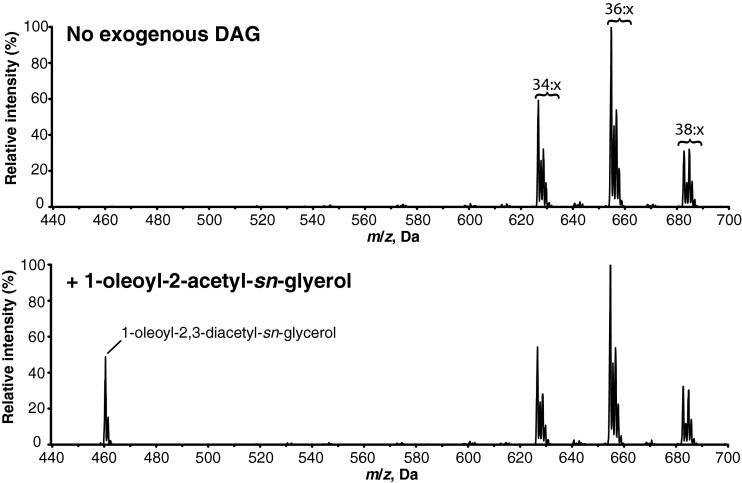
EaDAcT can acetylate DAG containing an sn-2 acetyl-groupPositive ESI mass spectra obtained from the neutral loss of ammonium acetate from lipid products resulting from incubating microsomes containing EaDAcT with acetyl-CoA and 1-oleoyl-2-acetyl-sn-glycerol. Peaks correspond to m/z values of the [M+NH4]+ adduct of the intact acetyl-TAG molecule. The number of acyl carbons in each series of acetyl-TAG molecules is indicated; for clarity, the number of double bonds (x) is not defined.